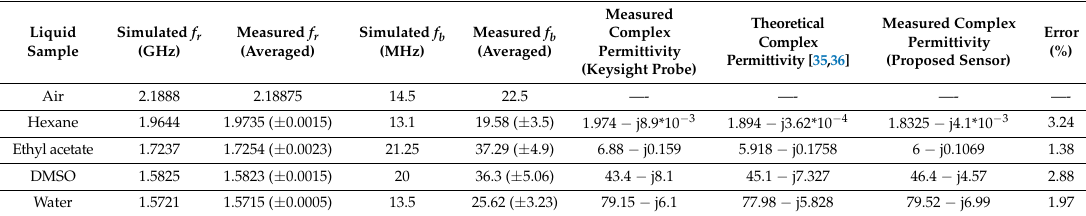
Figure 13. Simulated (solid lines) and measured (dash lines) transmission responses S 21 of the proposed sensor for various liquids. Table 2. Comparison between simulated and measured